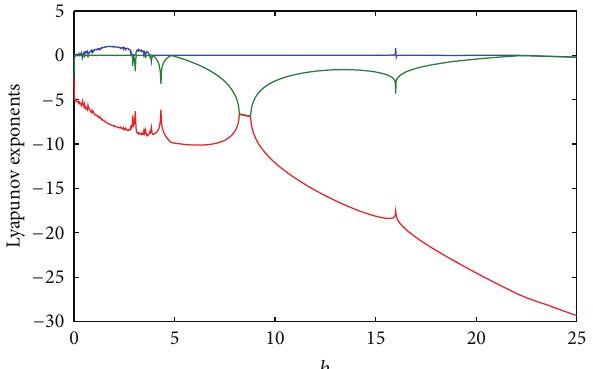
Figure 6: Bifurcation diagram of the system with respect to 𝑏 .